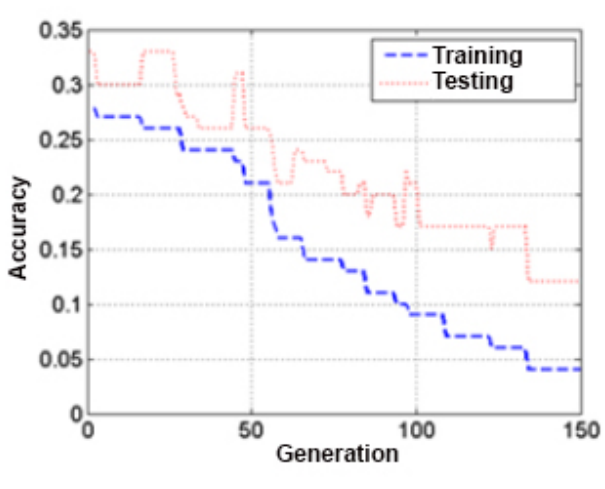
Figure 7. Problem model size Tic